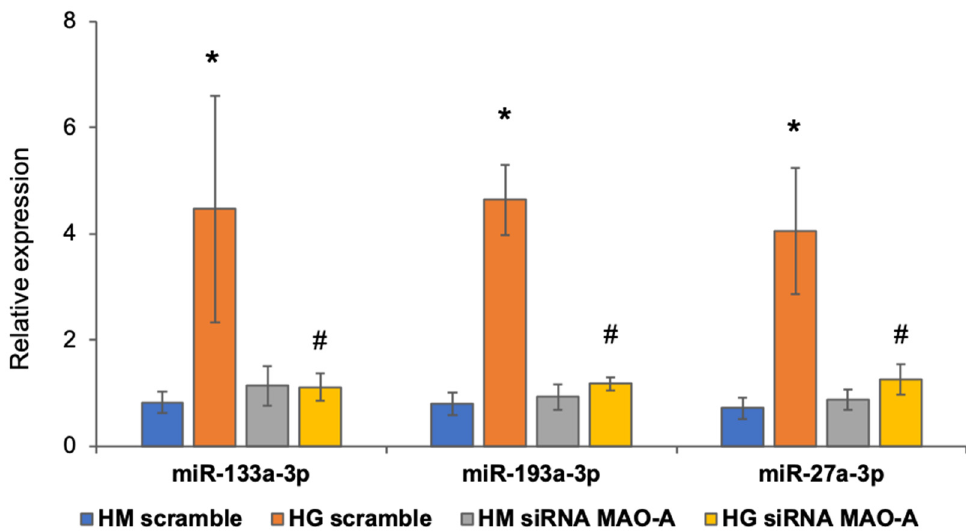
Figure 5. MiRNAs expression after MAO-A downregulation. MiRNAs expression was calculated through qRT-PCR relative to U6. Error bars indicate standard deviation calculated on at least three samples and three technical replicates per sample. Significance was calculated using t -test between samples considering unequal variance between samples. * p ≤ 0.05 vs. HM scramble; # p ≤ 0.05 vs. HG scramble.